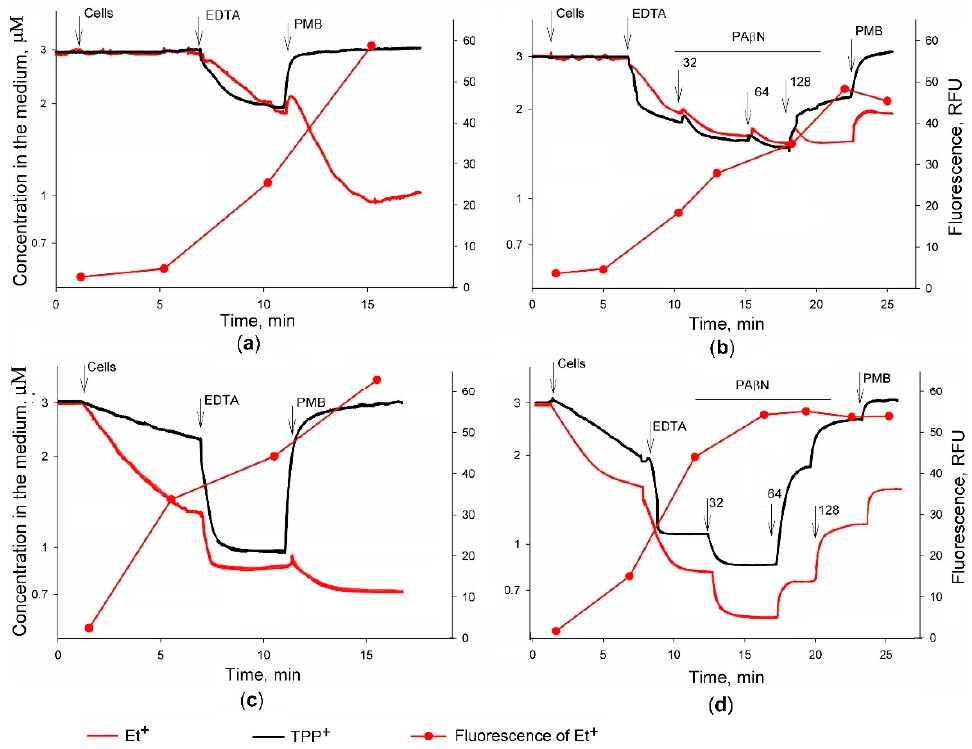
Figure 1. The accumulation of Et + and TPP + ions in S. typhimurium SL1344 wt ( a , b ) and ∆ tolC mutant ( c , d ) cells during simultaneous potentiometric and spectrofluorimetric assays. The measurements were performed at 37 ◦ C in 100 mM Tris/HCl buffer, pH 8.0, containing 0.1% glucose. The concentrated cell suspensions were added to obtain OD 600 of 1. EDTA was added to 1 mM and PMB to 50 mg/L. The final concentrations of PA β N ( µ M) are indicated in the figure ( b , d ). Samples of 75 µ L each were taken from the vessels to microtubes just before the indicated additions, and intensities of the fluorescence were immediately measured.